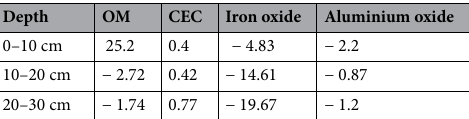
Table 4. Slopes of the linear fitting of the content of each sediment component in the direction of deep-water